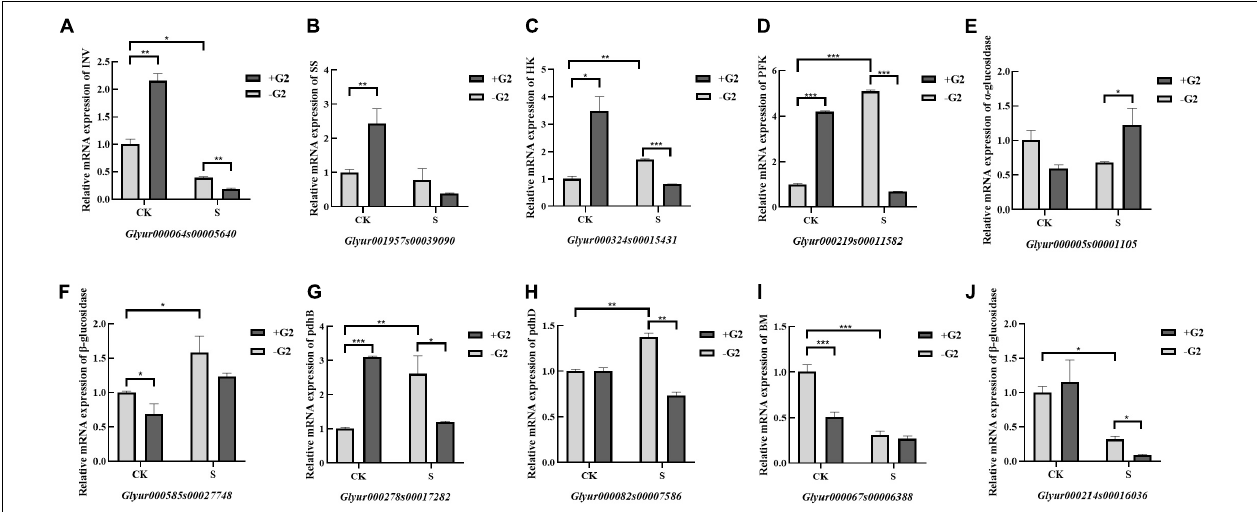
FIGURE 10 | Expression of carbohydrate metabolism-related genes (qRT-PCR) in G. uralensis in four treatments (CK, CK + G2, S, and S + G2). CK, control group; S, salt stress group; CK + G2, control combined with the G2 group; S + G2, salt stress combined with the G2 group (mean ± SD; * p < 0.05; ** p < 0.01; *** p < 0.001). (A) INV: beta-fructofuranosidase. (B) SS: sucrose synthase. (C) HK: hexokinase. (D) PFK: 6-phosphofructokinase 1. (E) α -glucosidase: alpha-glucosidase. (F,J) β -glucosidase: beta-glucosidase. (G) pdhB: pyruvate dehydrogenase E1 component beta subunit. (H) pdhD: dihydrolipoamide dehydrogenase (I) BM: